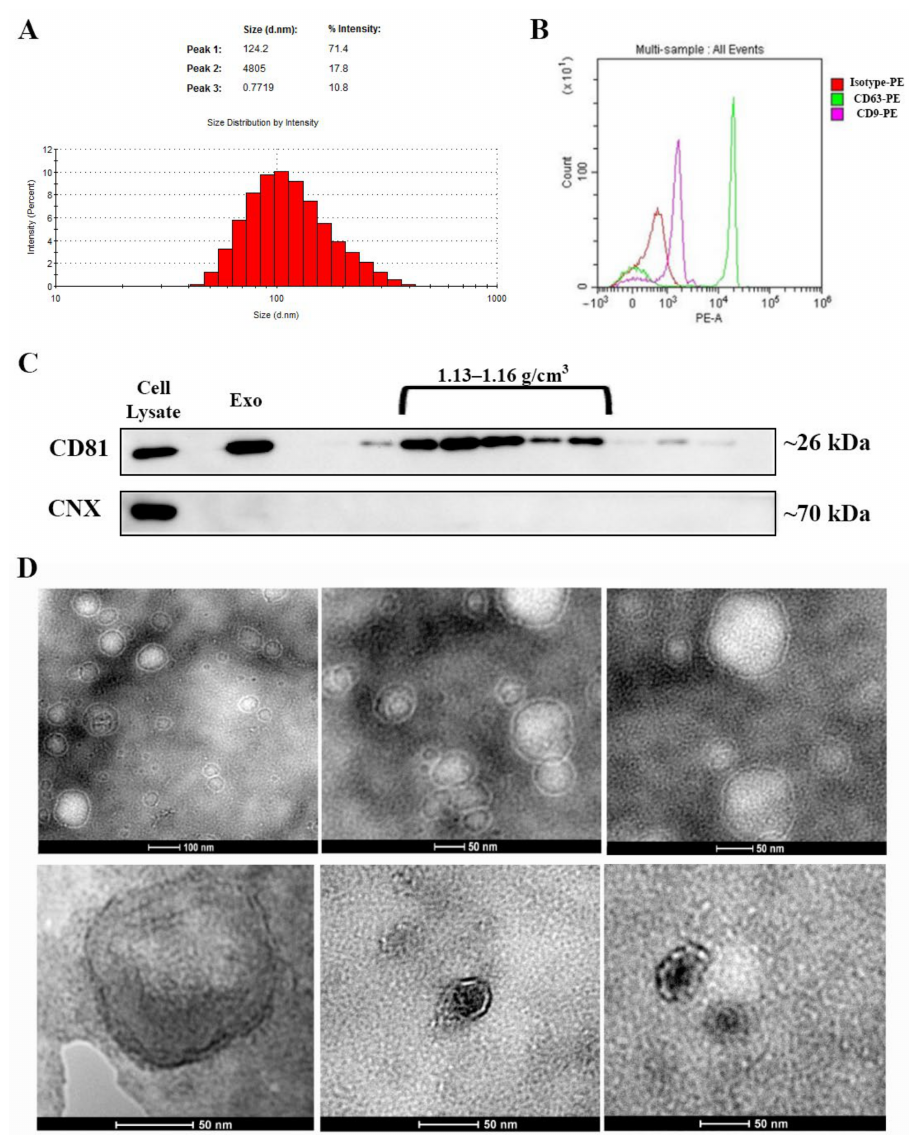
Figure 1. Characterization of exosomes isolated from bone marrow-derived MSC conditioned medium. ( A ) Histogram showing the distribution of the hydrodynamic diameter of the isolated exosomes by dynamic light scattering analysis. ( B ) Expression of exosomal markers CD63 and CD9 as revealed by flow cytometry and ( C ) CD81 as identified via Western blot for the whole pellet (Exo) as well as for the sucrose fractions derived from it. Note the absence of contaminants from the endoplasmic reticulum as indicated by the lack of calnexin (CNX) both in the exosomes (Exo) pellet and the sucrose fractions. ( D ) Transmission electron microscopy images depicting donut-shaped structures up to 100 nm (negative staining with phosphotungstic acid—upper panel and uranyl acetate—lower